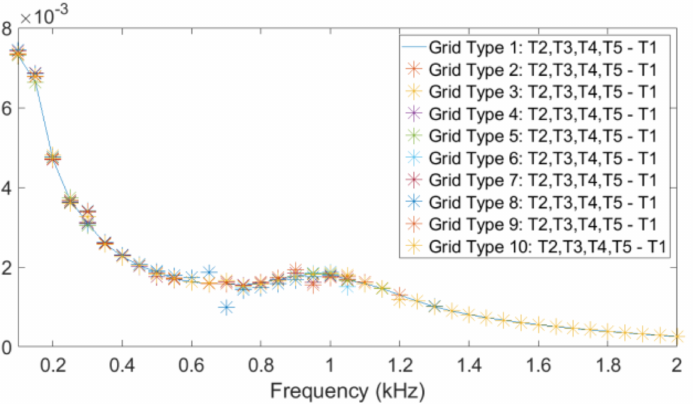
Figure 19. Impact of public grid impedance on overall transfer admittance (A/V) from turbine to turbine: 5-turbine wind power plant.